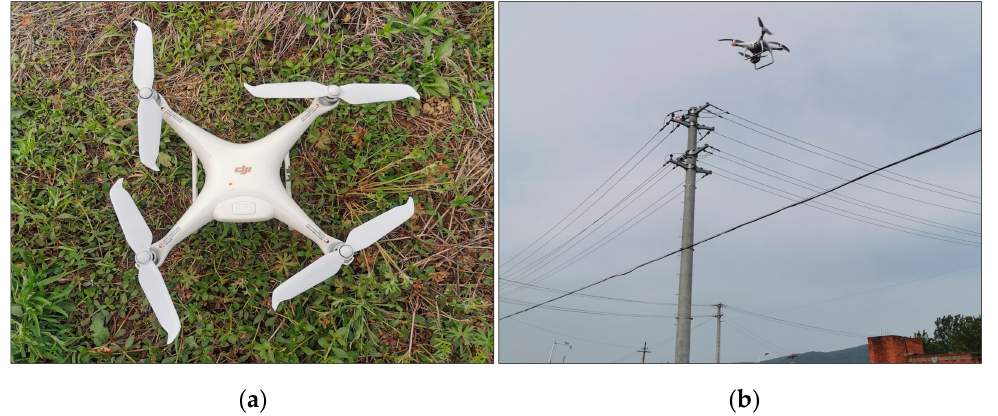
Figure 1. ( a ) Phantom 4 Pro V2.0 UAV; ( b ) Acquisition of inspection data by the UAV.